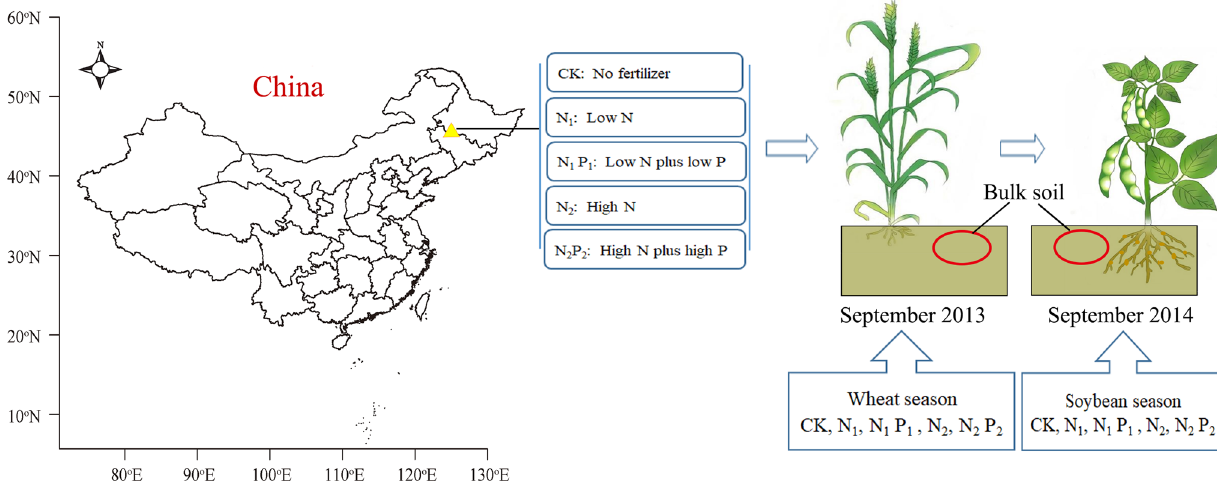
Figure 6. Experimental design and sample